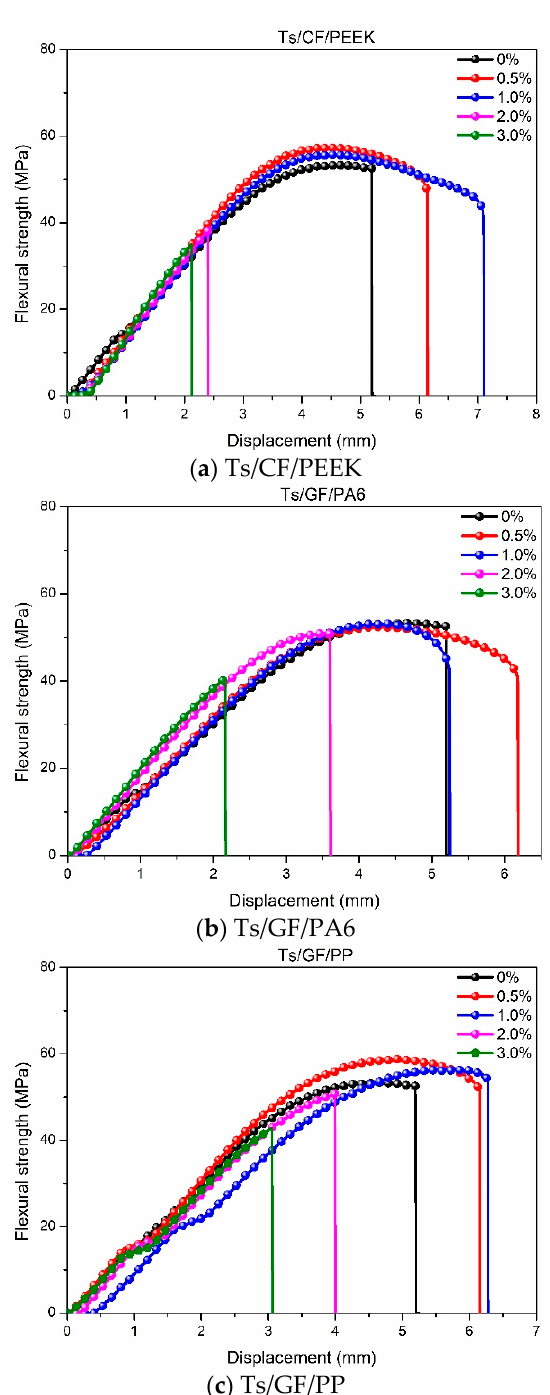
Figure 8. Effects of thermoplastic composite fillers on the flexural strength-displacement curves of Ts resin of ( a ) Ts/CF/PEEK, ( b ) Ts/GF/PA6 and ( c ) Ts/GF/PP.